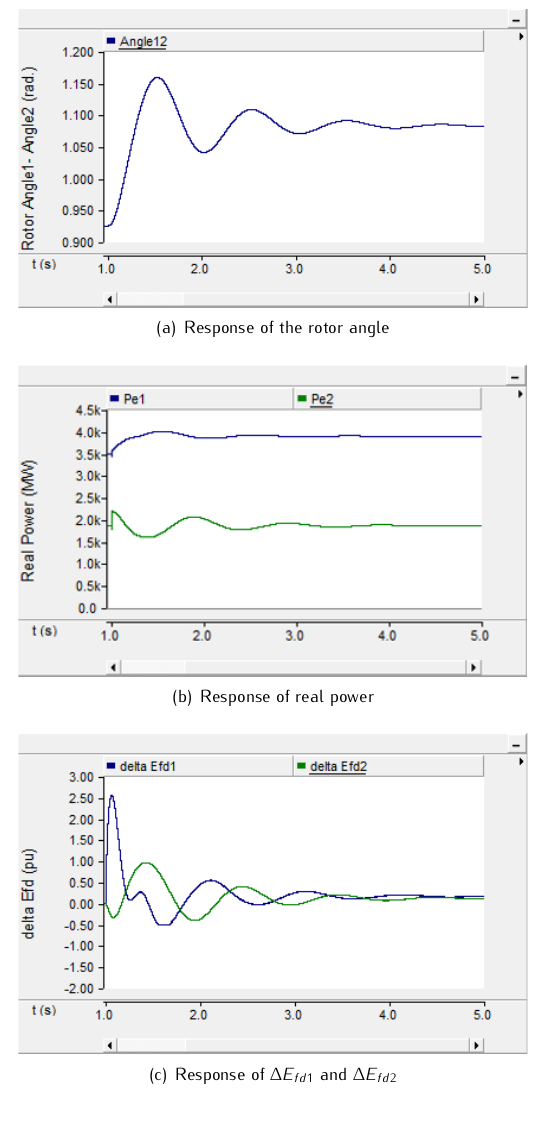
Figure 8. 400 MW increase of transfer power with H-infinity control Figure 8 400MW increase of transfer power with H-infinity control under other under other operating conditions. Figure 8 400MW increase of transfer power with H-infinity control under other Figure 8 400MW increase of transfer power with H-infinity control under other operating conditions operating conditions operating conditions